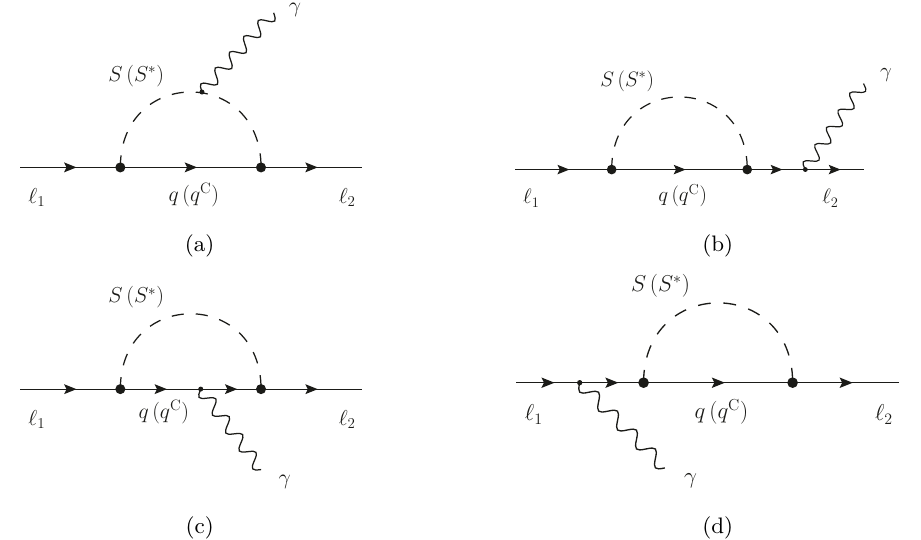
Figure 1. Feynman diagrams of the leading-order contribution to the ‘ 1 → ‘ 2 γ process from scalar